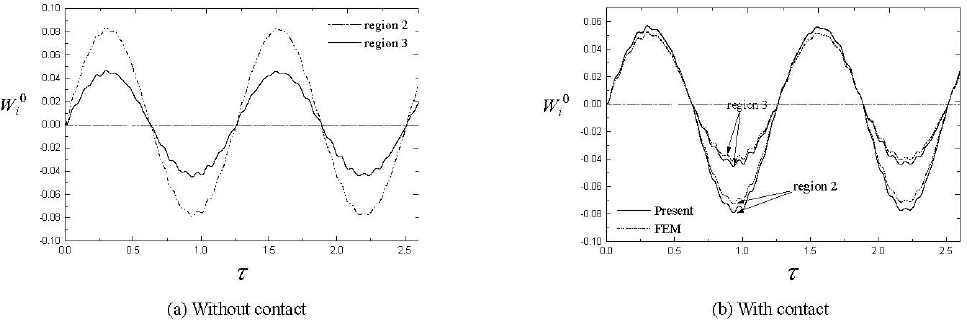
Figure 2. Nonlinear dynamic response curves of the mid-span point for the segments 2 and 3